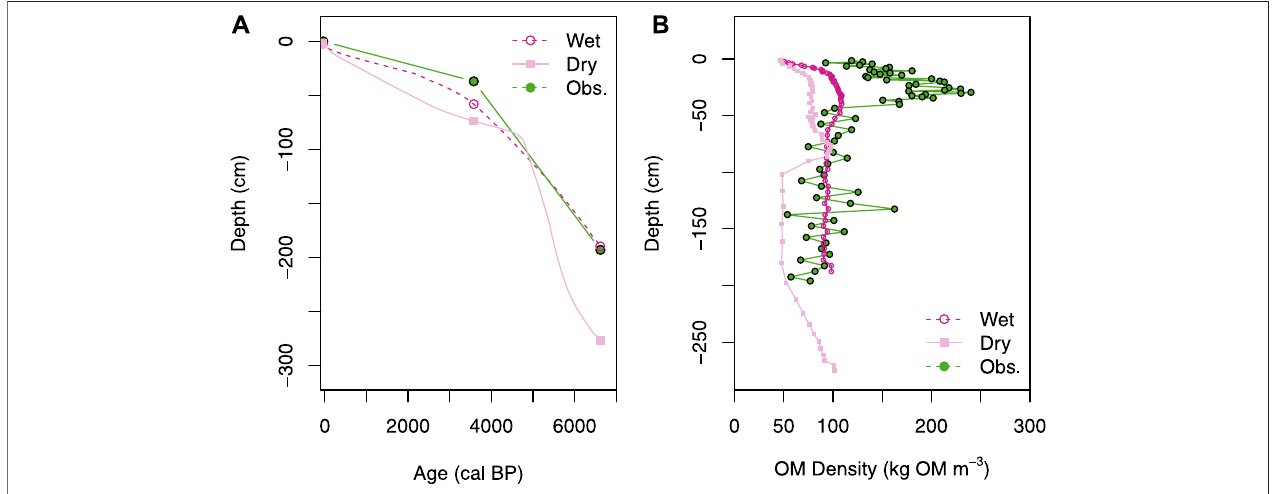
FIGURE 2 | Depth pro fi les for TKP for modeled scenarios (wet, dry landscapes) and observations (Obs.). (A) Modeled age-depth pro fi les (light pink and dark pink) are continuous with circles corresponding to the ages of the observations, while the green line connecting the observations is a linear interpolation between the three observed points. (B) Modeled and observed organic matter density with